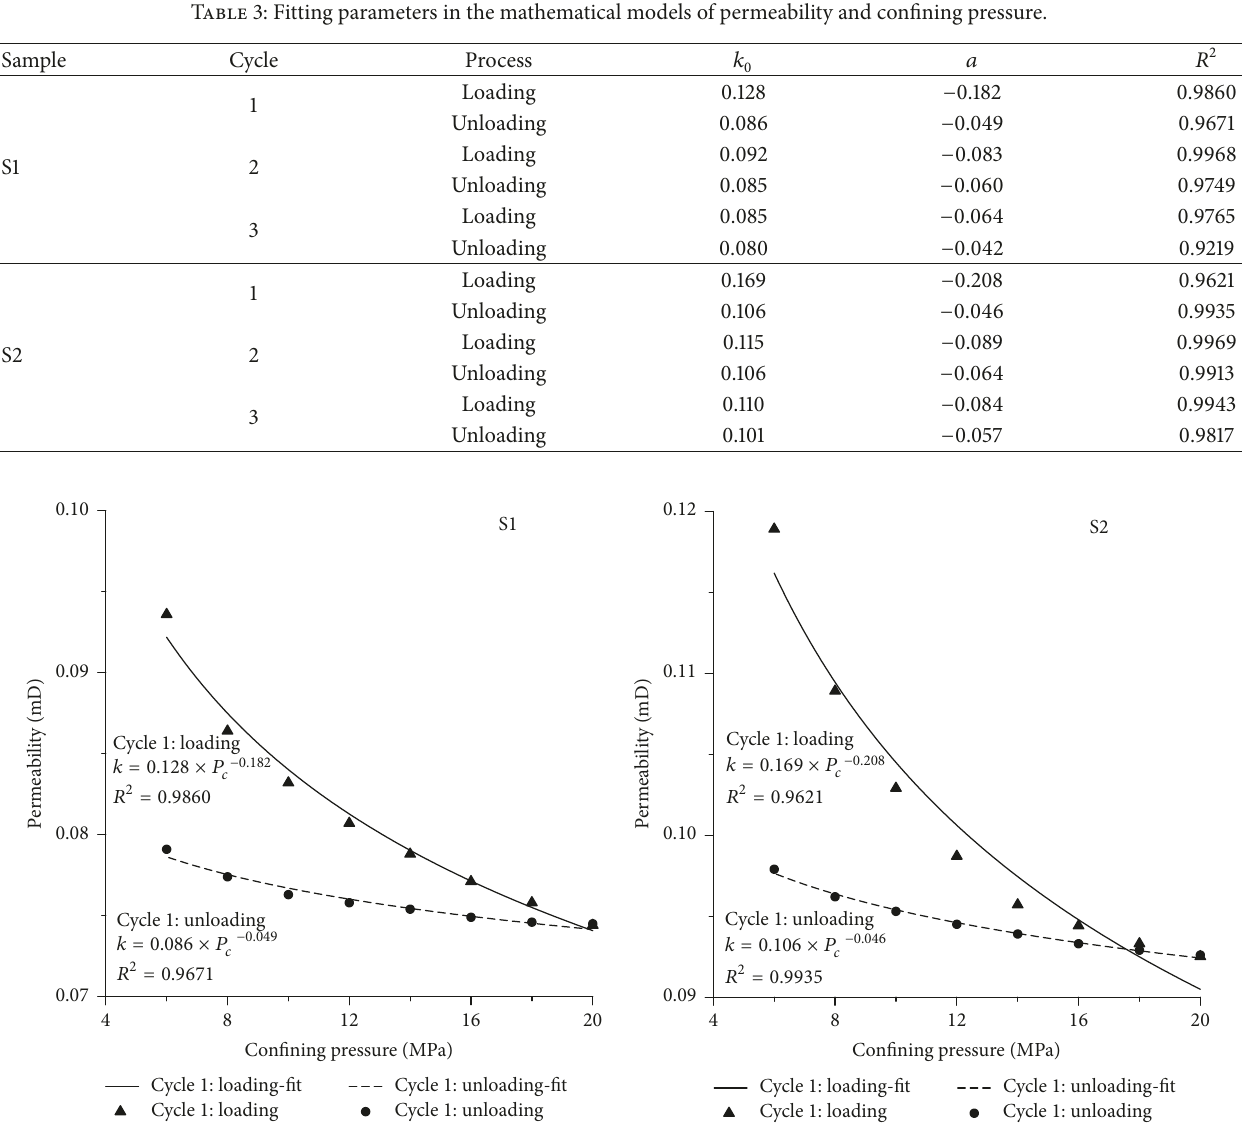
Figure 10: Fitting curves and mathematical models of the permeability and the confining pressure for the first cycle experiment.